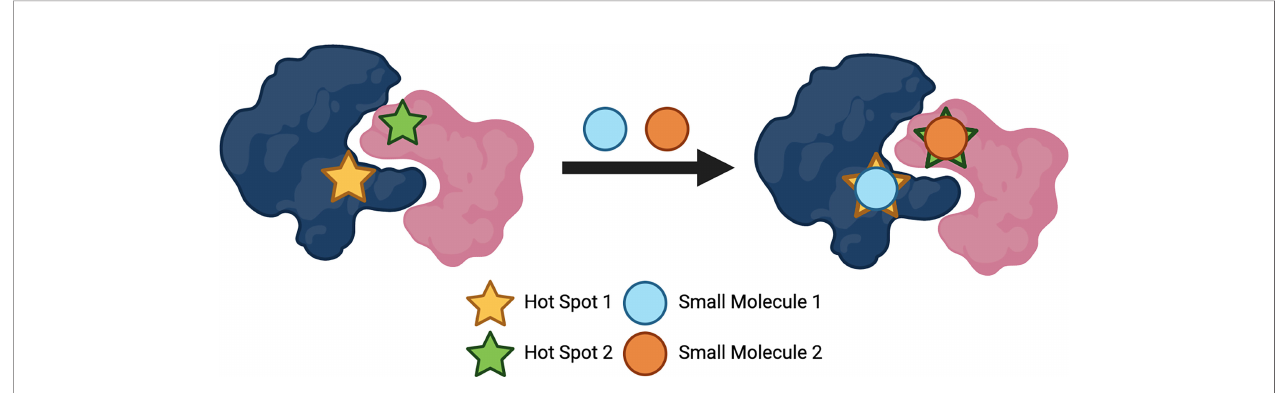
FIGURE 3 | Protein 'hot spots' used to target protein-protein interactions (PPIs). Created with